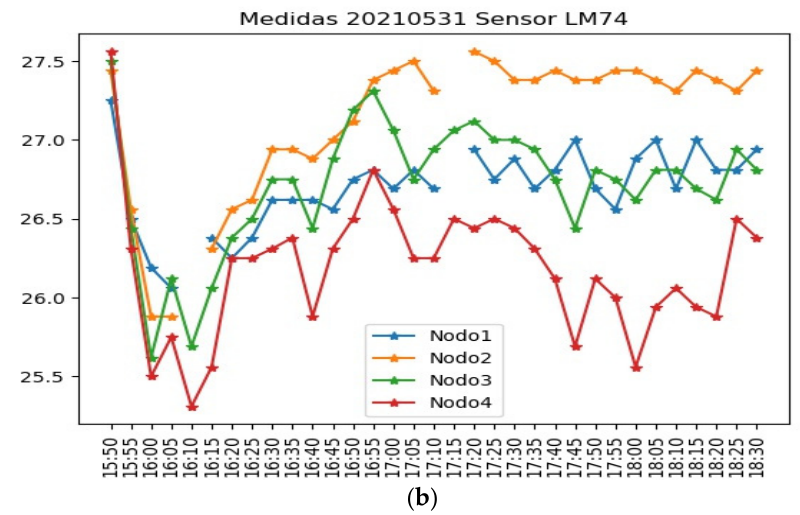
Figure 11. ( a ) eCO 2 measurements (CCS811); ( b ) Temperature measurements (TMP37).